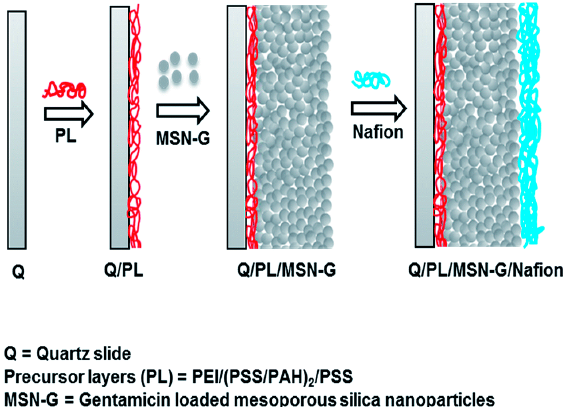
Figure 12. Pictorial presentation of thin film preparation of MSNs coated with Nafion. Reproduced with permission from reference [59].